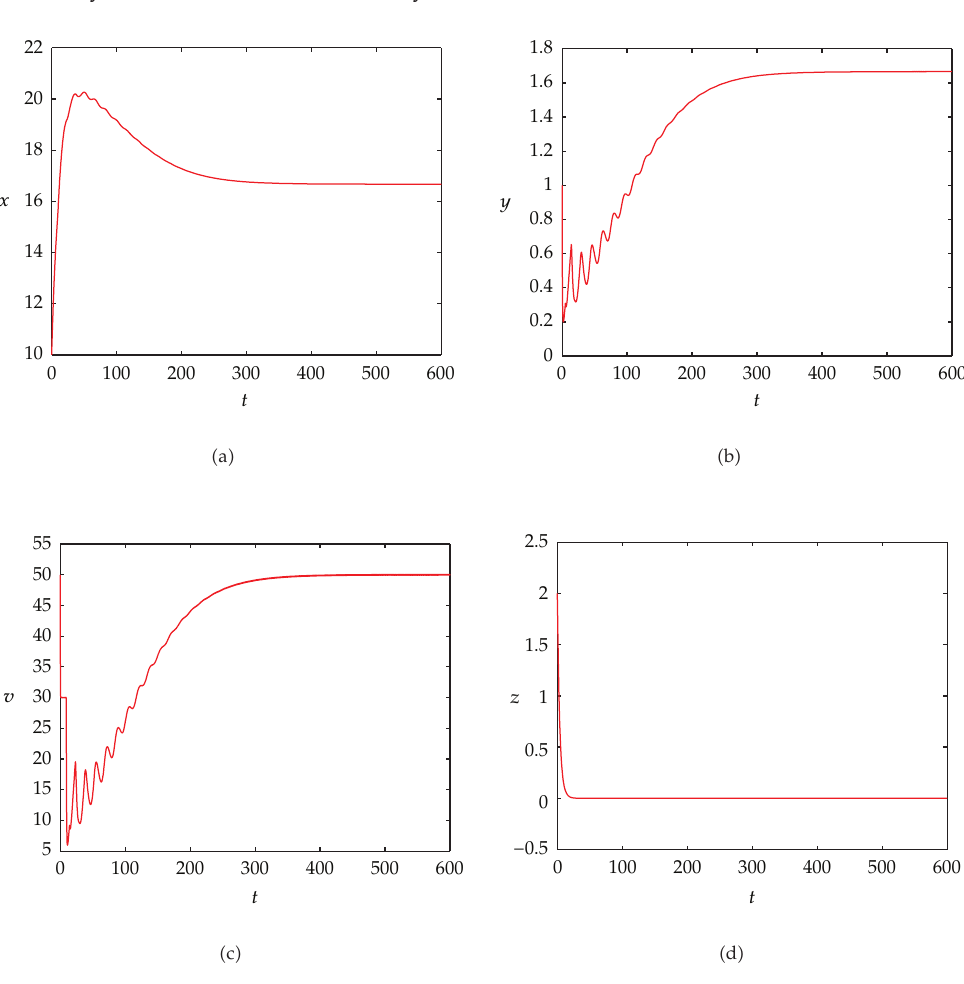
Figure 2: The CTL-inactivated infection equilibrium E 1 of system (cid:2) 1.2 (cid:3) is globally asymptotically stable. Here τ 1 (cid:7) 5, τ 2 (cid:7) 9, and the initial value is (cid:2) x 0 (cid:7) 10 , y 0 (cid:7) 1 , v 0 (cid:7) 50 , z 0 (cid:7) 2 (cid:3)